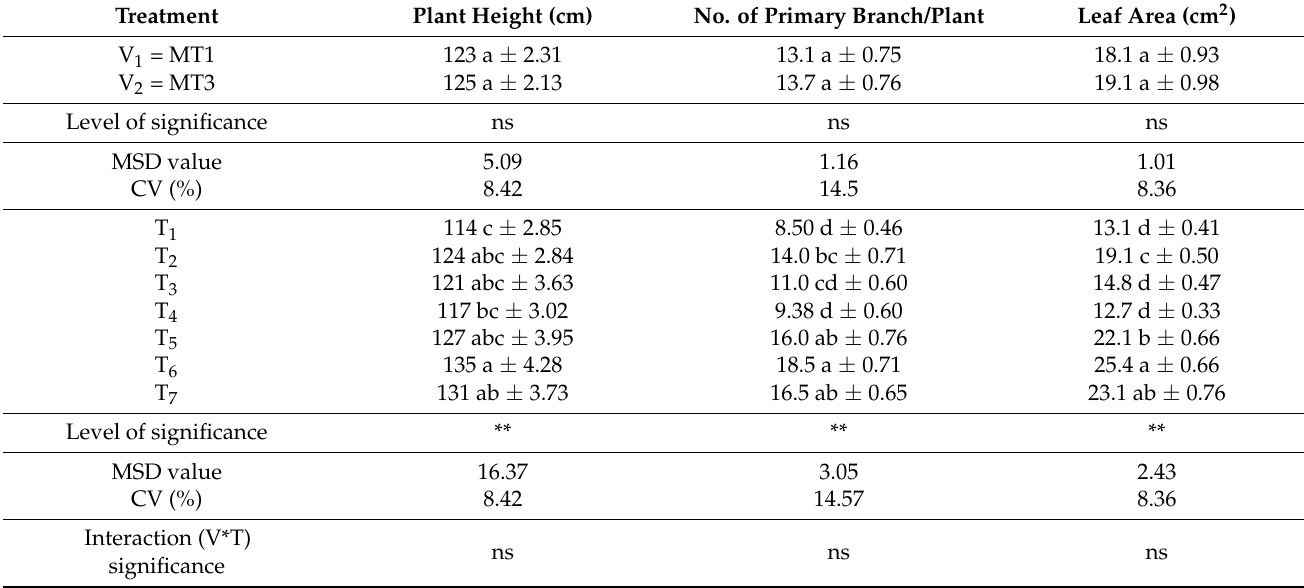
Table 2. Effect of zinc fertilizer and zinc oxide nanoparticles on growth parameters of two selected tomato